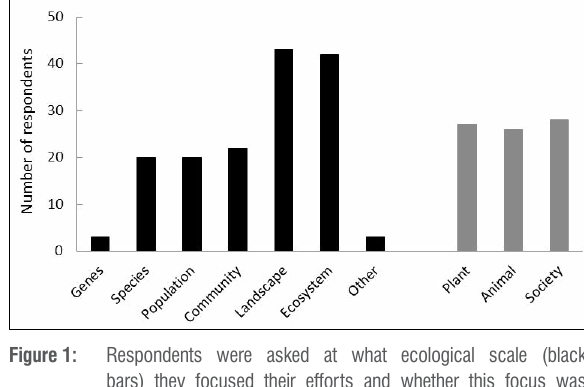
Respondents were asked at what ecological scale (black bars) they focused their efforts and whether this focus was predominantly on plants, animals or society (grey bars). Respondents ( n =53) could choose more than one focus area in each